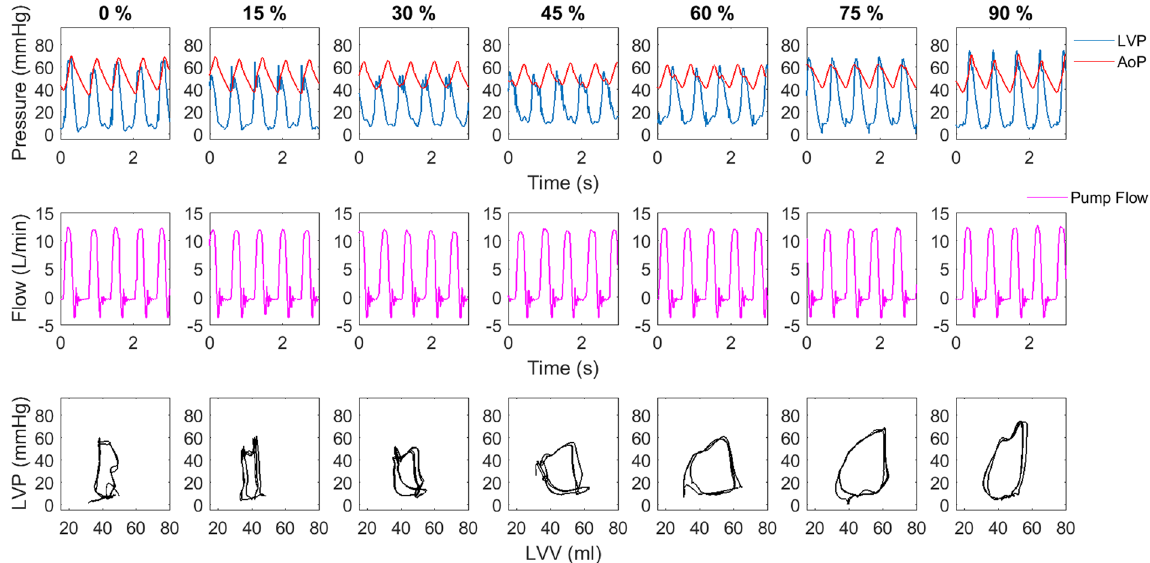
Figure 5. Typical time courses of pressure and flow at different phase delays (upper and mid panel) at a cardiac output of 3.4 L/min. In the lower panel the respective PV loops are